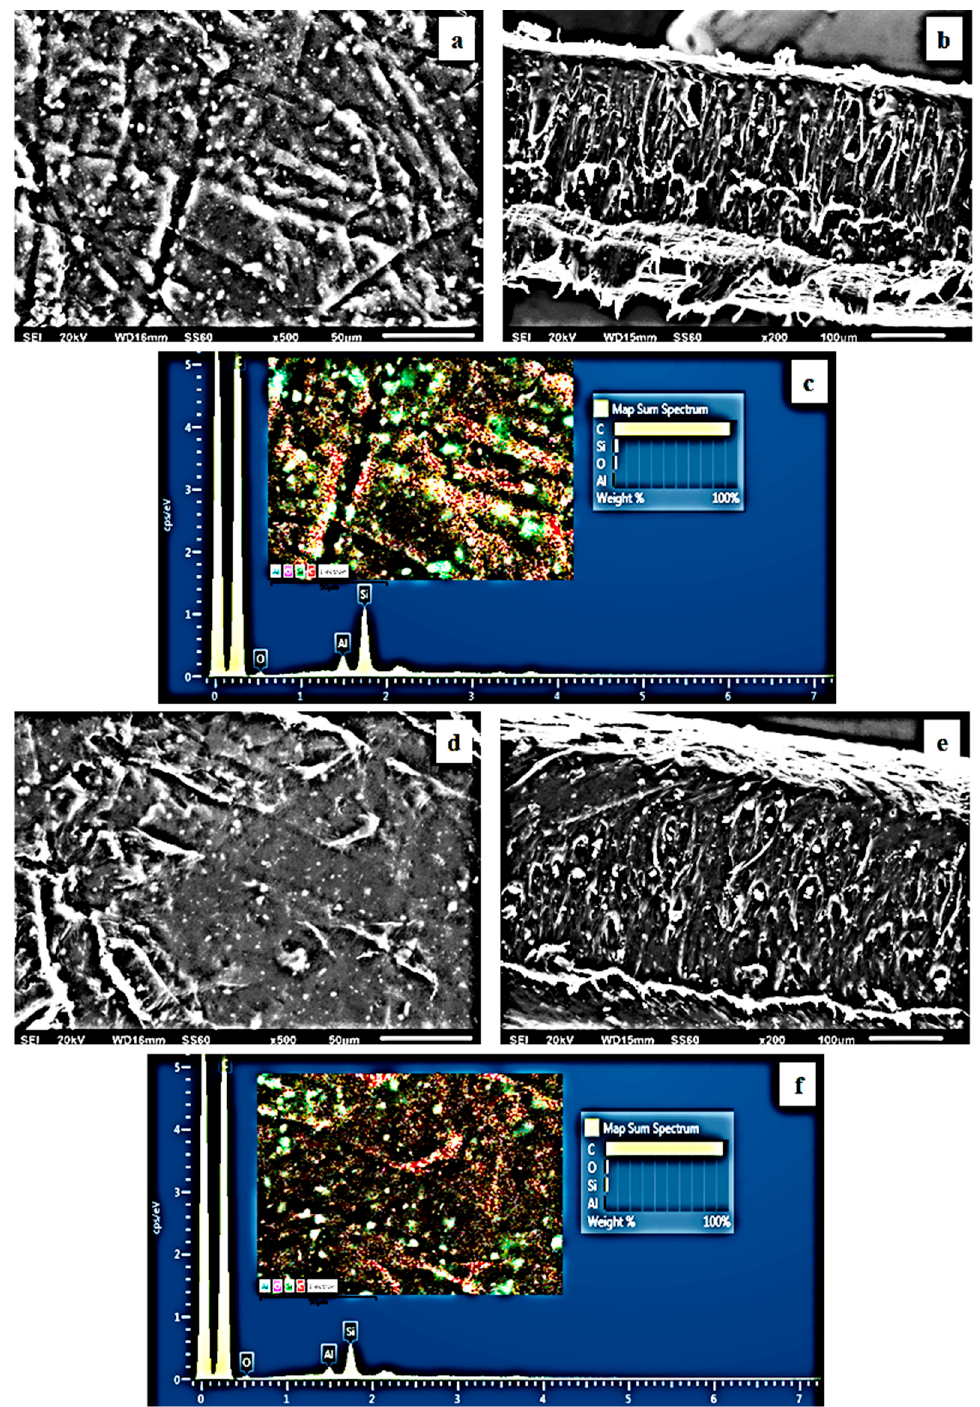
Figure 7. ( a , d ) SEM images of surface and ( b , e ) cross-section of the nanocomposite films of LDPE/15NZ ( a , b ) and LDPE/15TO@NZ ( d , e ), respectively. ( c , f ) Energy-dispersive spectrometer (EDS) spectra, relative elemental analysis, and mapping of the surface from the SEM images at ×1000 magnification.